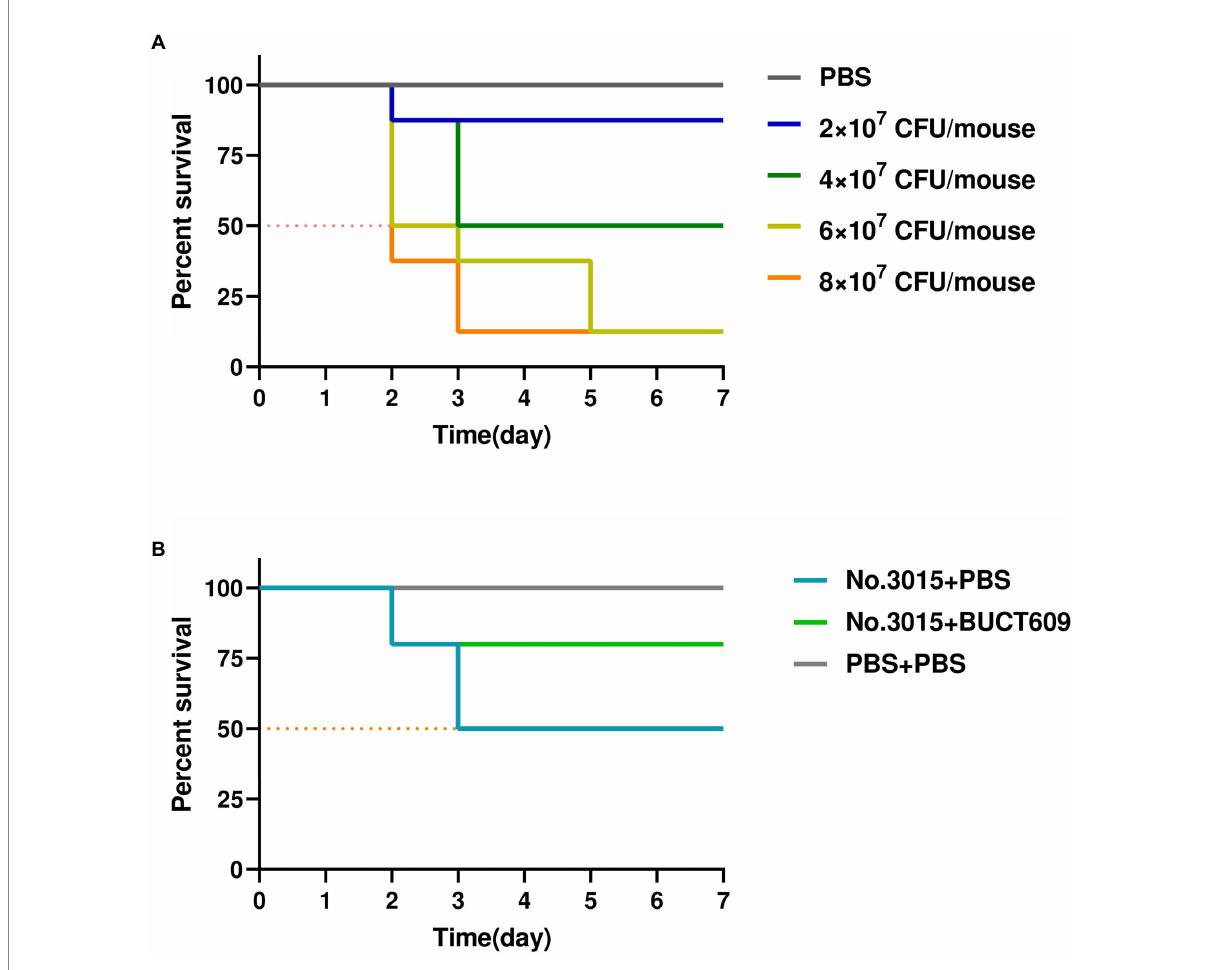
FIGURE 5 Antibacterial effect of BUCT609 in vivo . (A) Determination of median lethal dose. The daily percent survival of mice at different titers of bacterial doses. The LD50 was determined as 4 × 10 7 CFU/ml. When the titer of No.3015 was 4 × 10 7 CFU/ml, the survival rate of mice was 50%. (B) Antibacterial effect of BUCT609 in vivo . The daily percent survival of mice before and after treatment. After the treatment, the mice had a survival rate of up to 80%, which was 30% higher than no